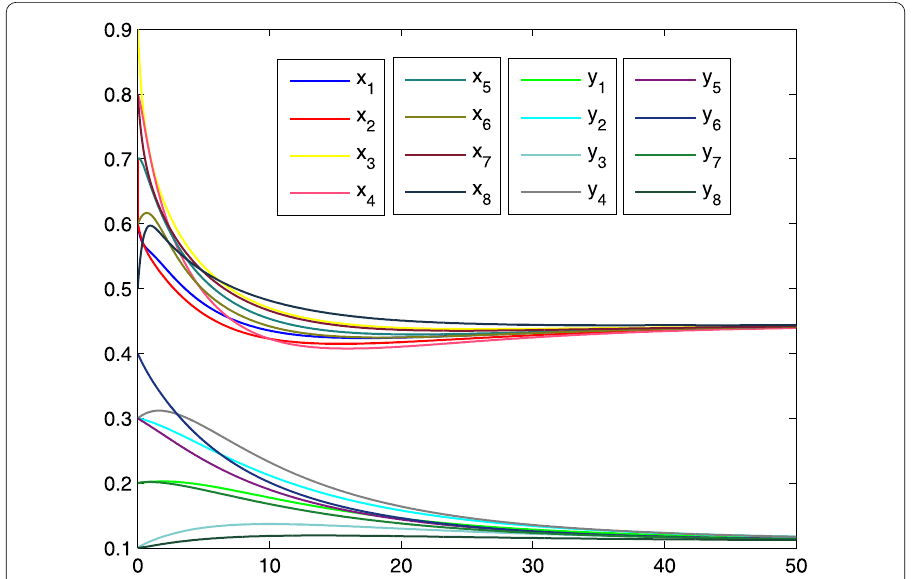
Figure 1 The solution of coupled predator-prey model with time-varying dispersal coefficient-matrix D 1 ( t ) when l =